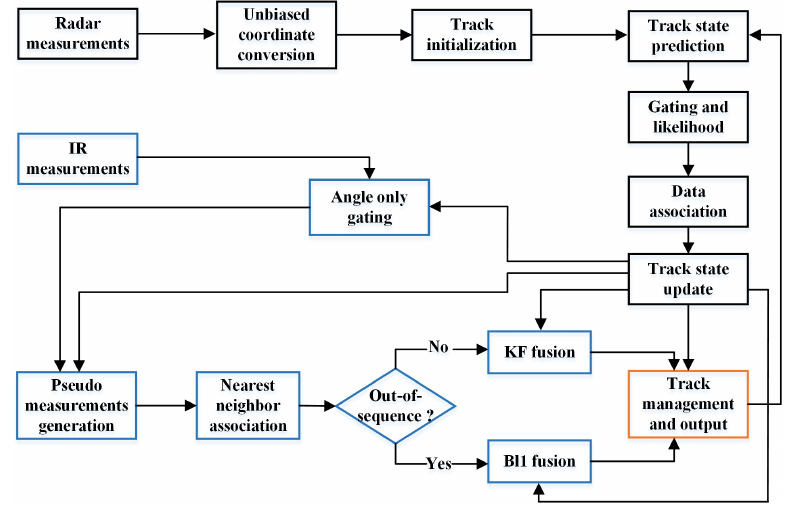
Figure 2. Block diagram of the Proposed